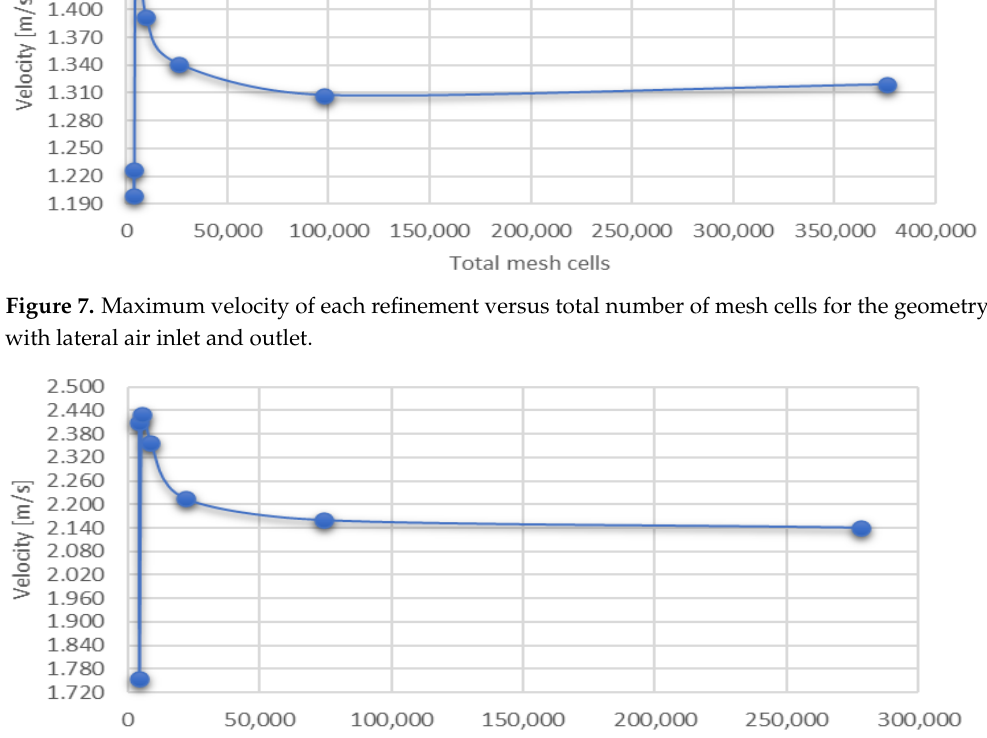
Figure 8. Maximum velocity of each refinement versus total number of mesh cells for the geometry with upper air inlet and outlet.